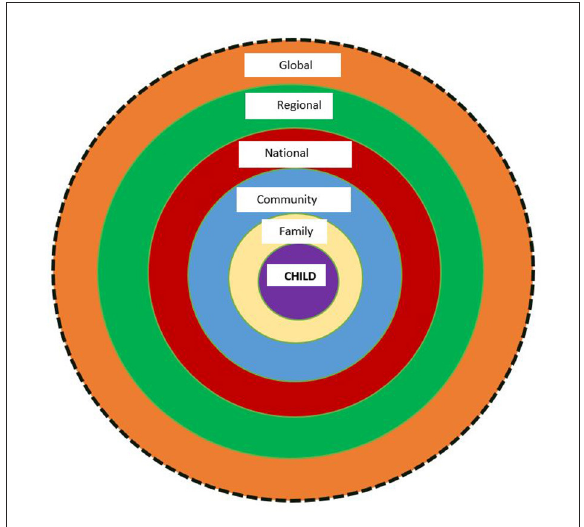
FIGURE1 Mapping different levels of interventions to address VAC in Qatar (Adapted from Kelly et al. (28)).